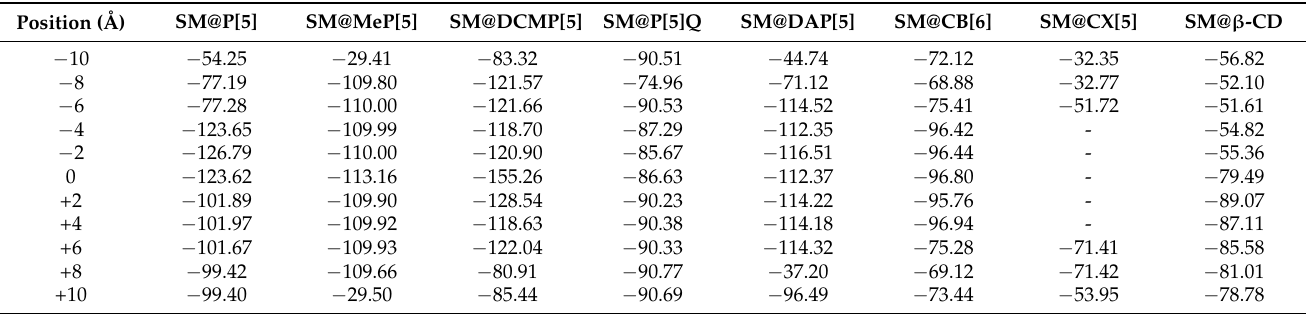
Figure 3. Coordinate systems of the complexation process of SM and eight macrocyclic molecules and the molecular structures of the most stable host-guest complexes. Atom colors: chlorine (green); oxygen (red); carbon (grey); sulfur (yellow); nitrogen (blue) and hydrogen (white). Table 4. Complexation energies (kJ/mol) between SM and the eight studied macrocycles calculated with r 2 SCAN-3c in the gas